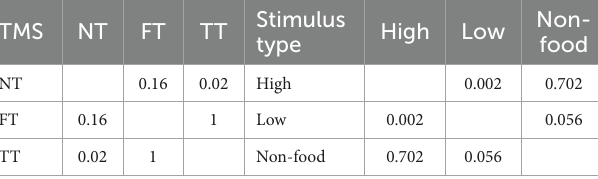
TABLE 4 Accuracy post-hoc results.